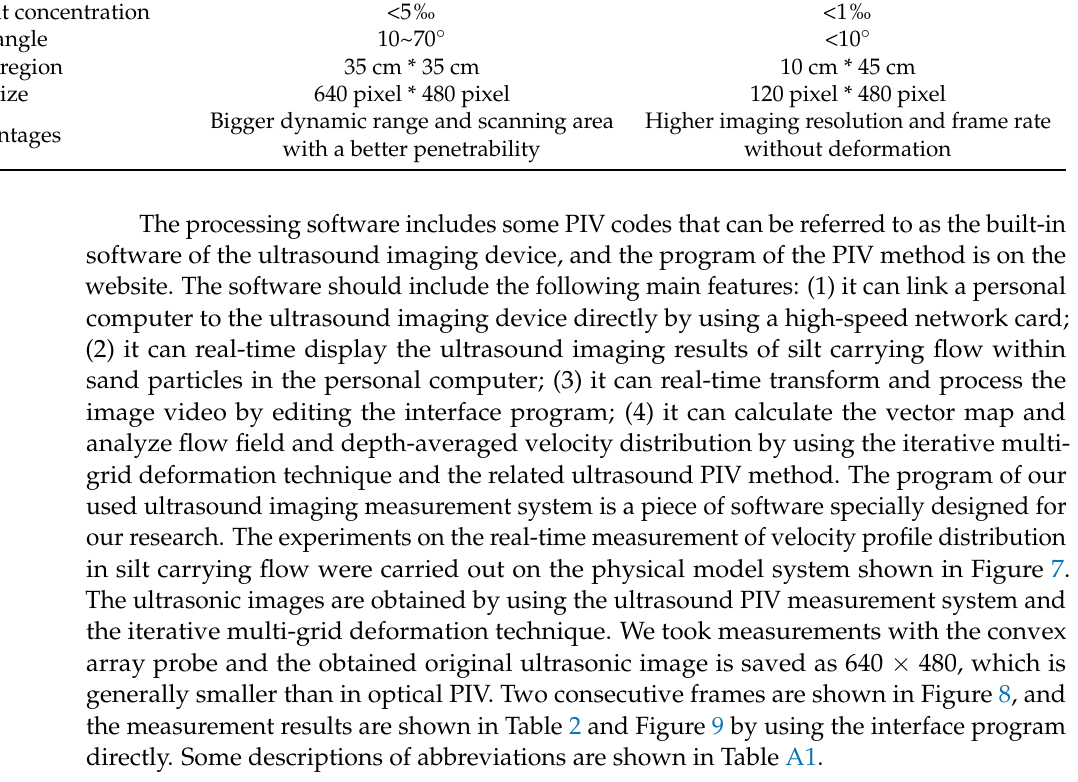
Figure 8. Two consecutive frames of ultrasonic images at t and t + ∆ t . ( a ) The ultrasound image at t ( b ) The ultrasound image t + ∆ t